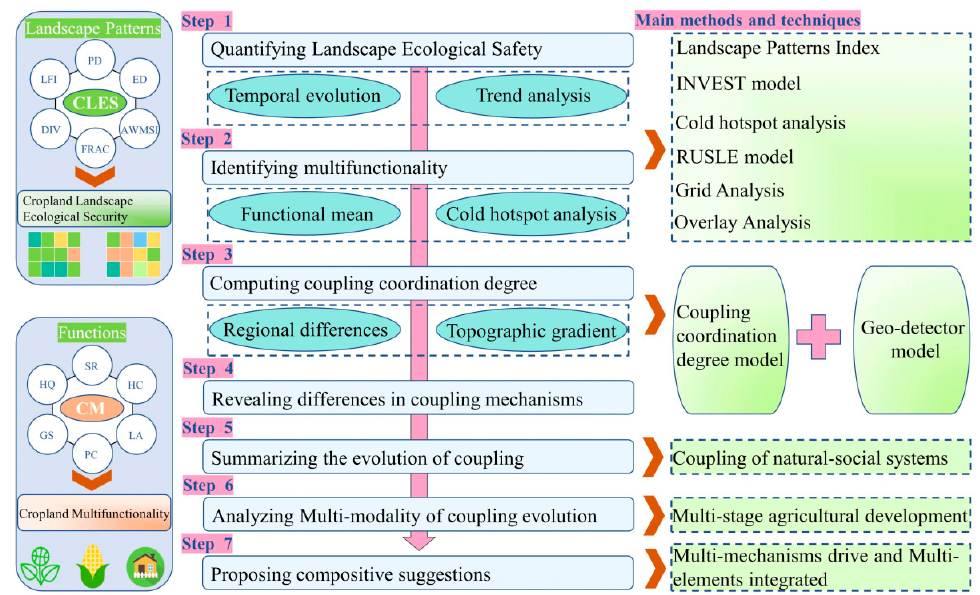
Figure 2. A flowchart used for analyzing the relationship between CLES and CM.